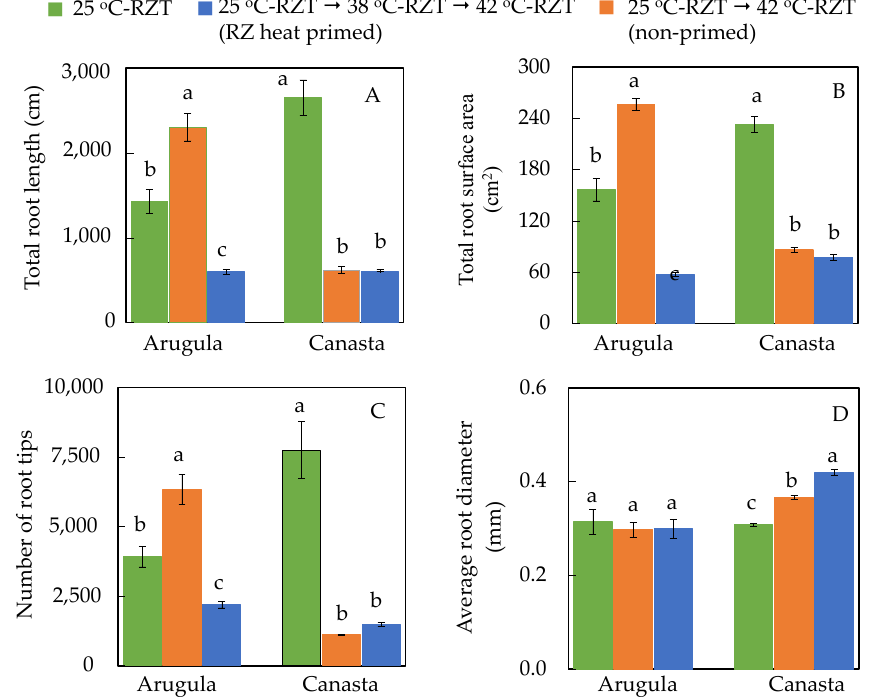
Figure 5. Total root length ( A ), total root surface area ( B ), total number of root tips ( C ) and average root diameter ( D ) of Arugula and Canasta at harvest (36 DAT). The vertical lines through the means represent standard errors ( n = 4). Different lowercase letters are statistically different ( p < 0.05, Tukey’s multiple comparison test). Each species was analyzed separately. Refer to Section 4.2 for further details on different RZT treatments.